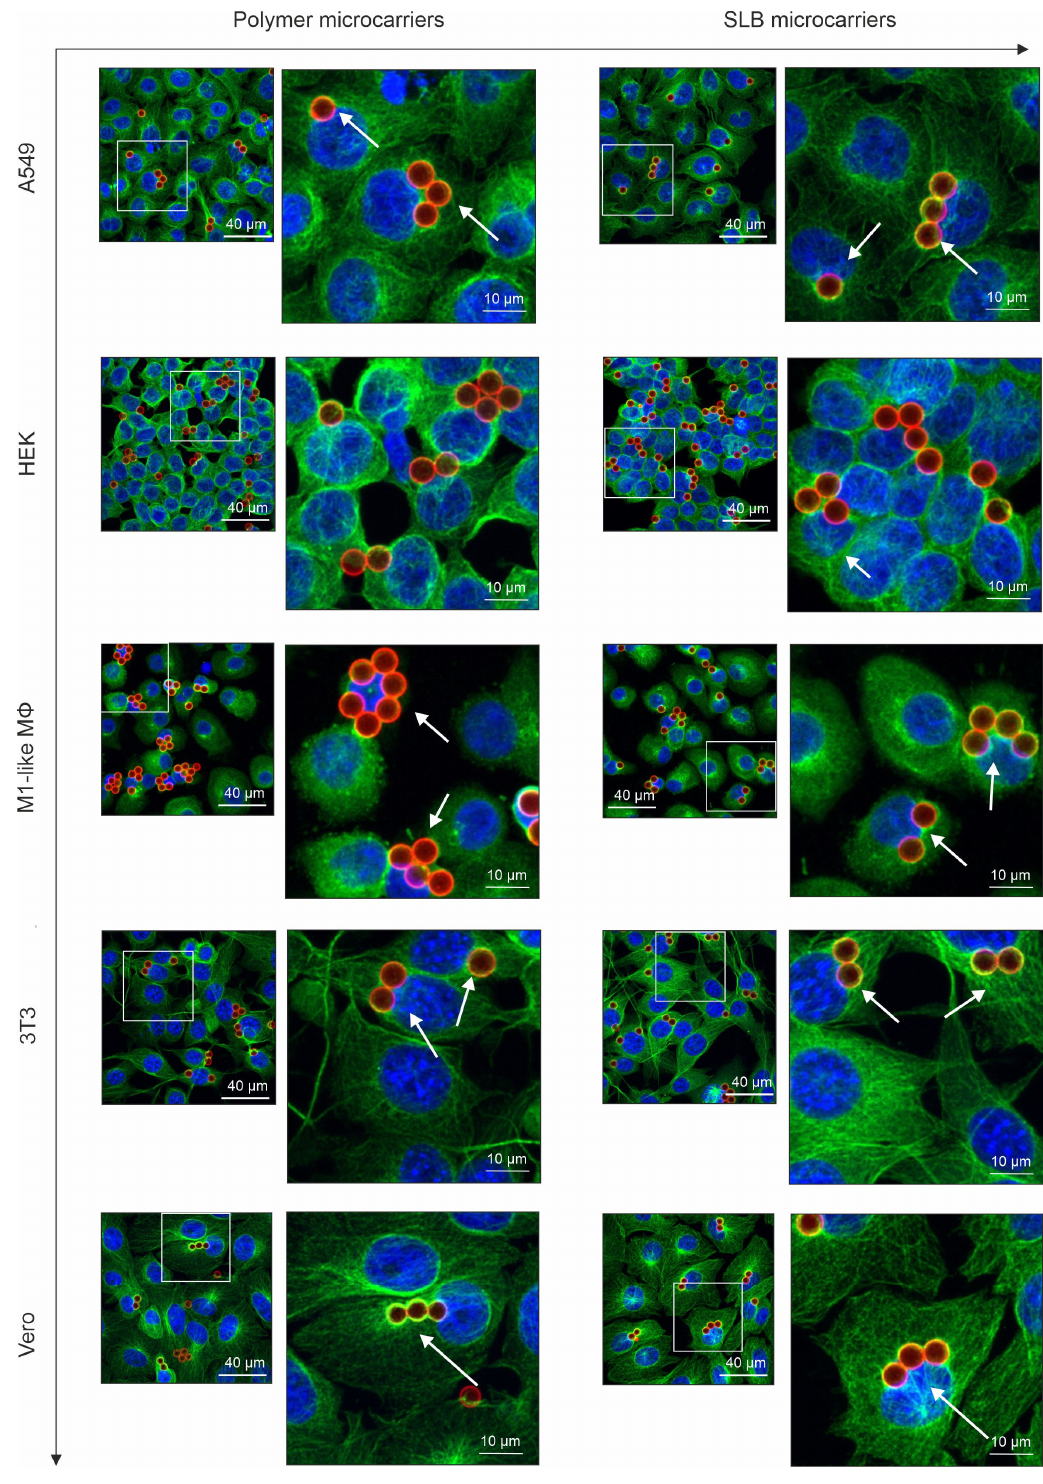
Figure 4. The association of microcarriers with microtubule filaments and their localization in a perinuclear area in different human and animal cell types and M1-like M Φ . Immunofluorescence analysis was performed after incubation of indicated cell types with polymer and SLB microcarriers for 16 h. The images were obtained after maximum intensity projections and the overlays show nuclei in blue (counterstained with DAPI), microtubule filaments in green (application of anti- α -tubulin antibodies) and microcarriers in red (labelling with RITC). The insets depict a higher magnification of indicated areas to reveal association of microcarriers with microtubule filaments (indicated by white arrows). Image size of the unzoomed images: 145 µm × 145 µm, zoom-ins: 58 µm × 58 µm.